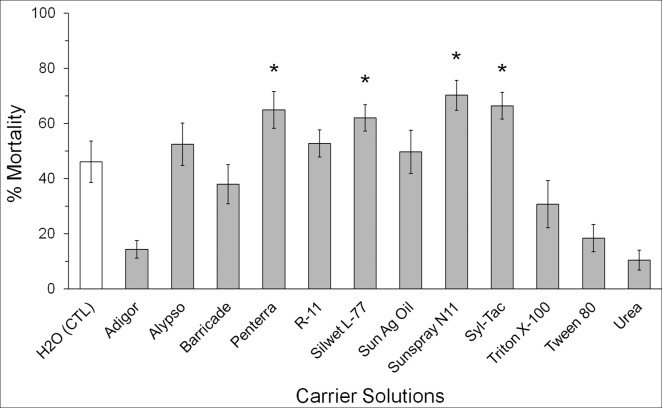
Mortality of wheat stem sawfly (Cephus cinctus) from wheat stubble treated with three species of EPNs (Heterorhabditis bacteriophora, Steinernema feltiae, and Steinernema riobrave) combined with different carrier solutions.Percent mortalities were pooled across EPN species and bars represent average percent mortality (mean ± SEM) for each treatment solution (N = 9). Asterisks indicate significant differences in percent mortality (Dunnett’s test, α = 0.05) compared to controls (H2O).